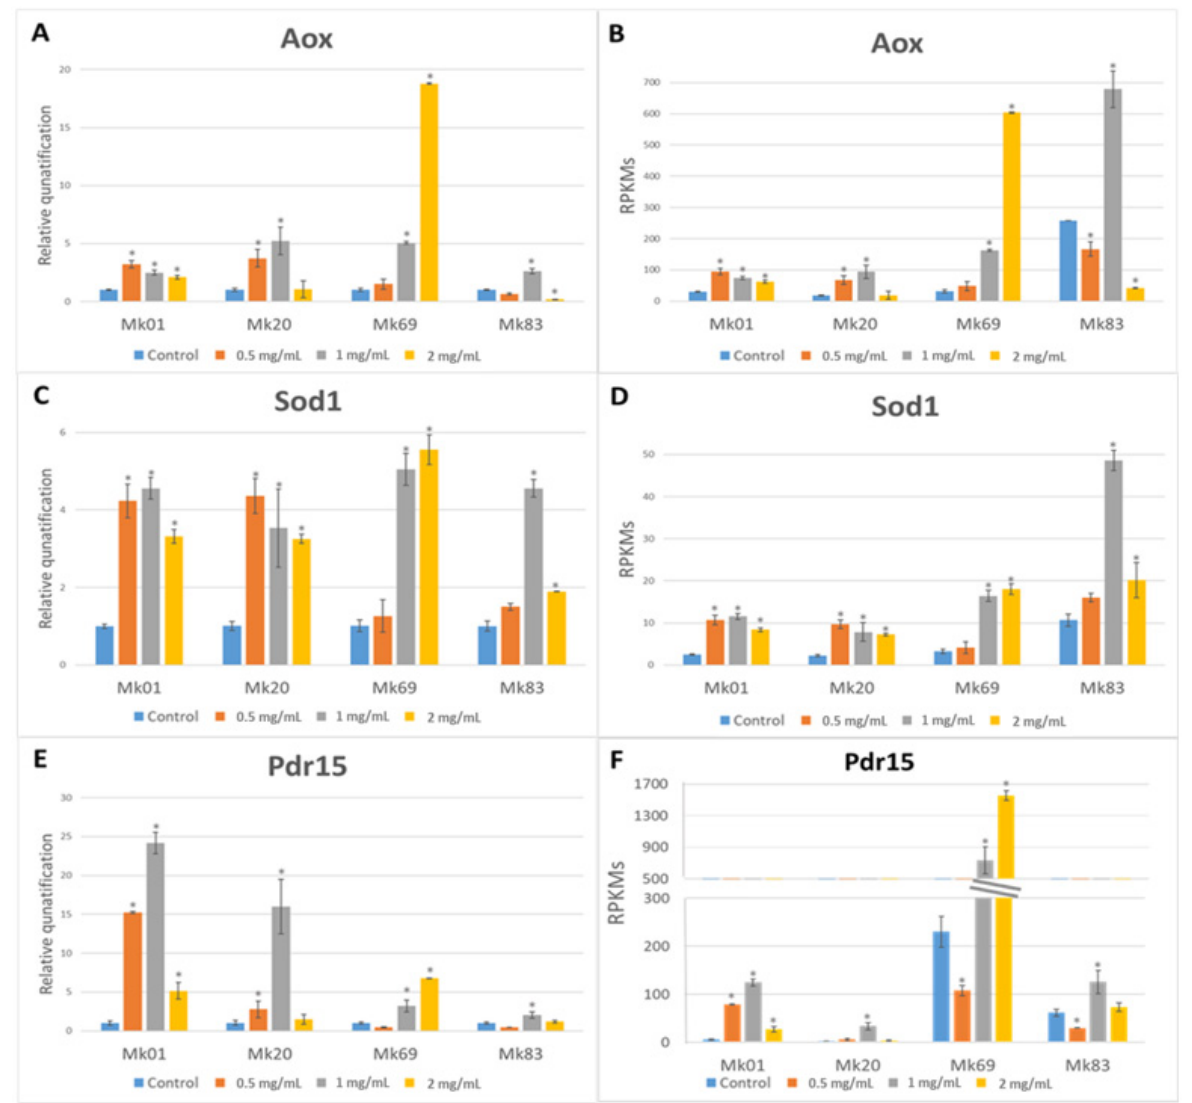
Figure 6. Effect of chitosan on Aox , Sod1 and Pdr15 expression. Relative quantification of the expression of ( A ) Aox gene, ( C ) Sod1 gene, and ( E ) Pdr15 gene in mycelia of fast (Mk01 and Mk20) and slow (Mk69 and Mk83) growing monokaryons grown on MESM containing different chitosan concentrations (0.5, 1, and 2 mg/mL). ( B , D , F ) estimate the RPKM values for Aox , Sod1, and Pdr15 genes under different chitosan concentrations. Individual RPKMs were estimated using the RPKM values retrieved from the RNA-seq as the control multiplied by the relative quantification of the transcript obtained after RT-qPCR analysis of each monokaryon grown under different doses of chitosan. Asterisks indicate significant differences between control and chitosan doses (Tukey’s test, p -value < 0.05). That is, the relative expression of the Aox gene at 1 mg/mL in Mk69 was 5.0 fold the control. Assuming that the RPKM values obtained by RNA-seq were 32.1, the estimated RPKM values for the Aox gene would be